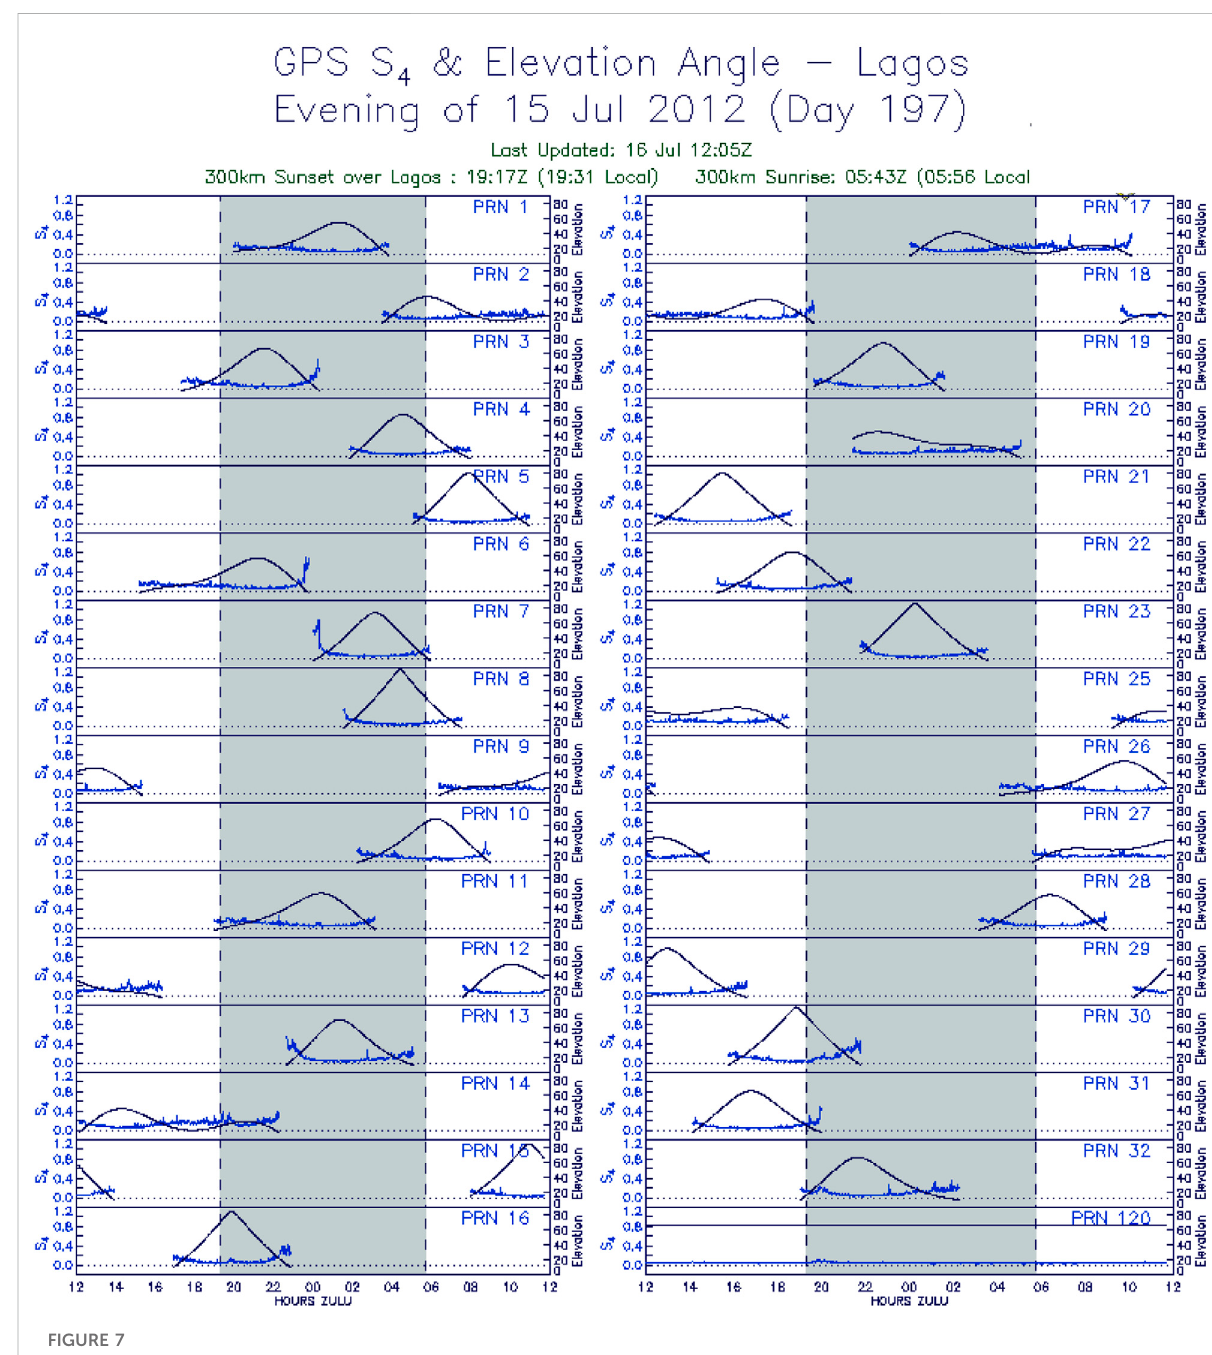
FIGURE 7 Scintillation plots per satellite for the Lagos SCINDA GPS receiver, with coordinates: 6.5166646 3.38499846, for 15 July